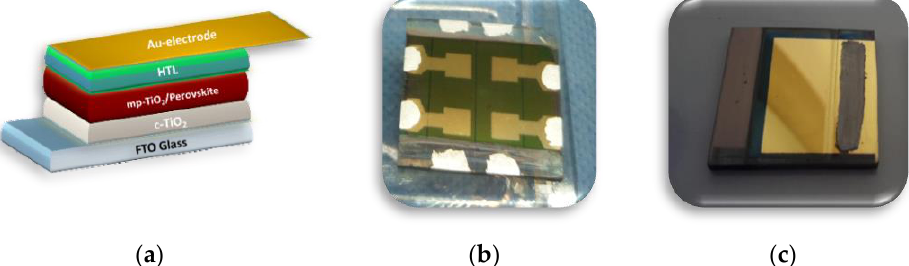
Figure 1. ( a ) Perovskite solar cell full stack: ( b ) four small area (0.09 cm 2 ) cells and ( c ) one large area (1.01 cm 2 ) cell on 2.5 × 2.5 cm 2 substrates.